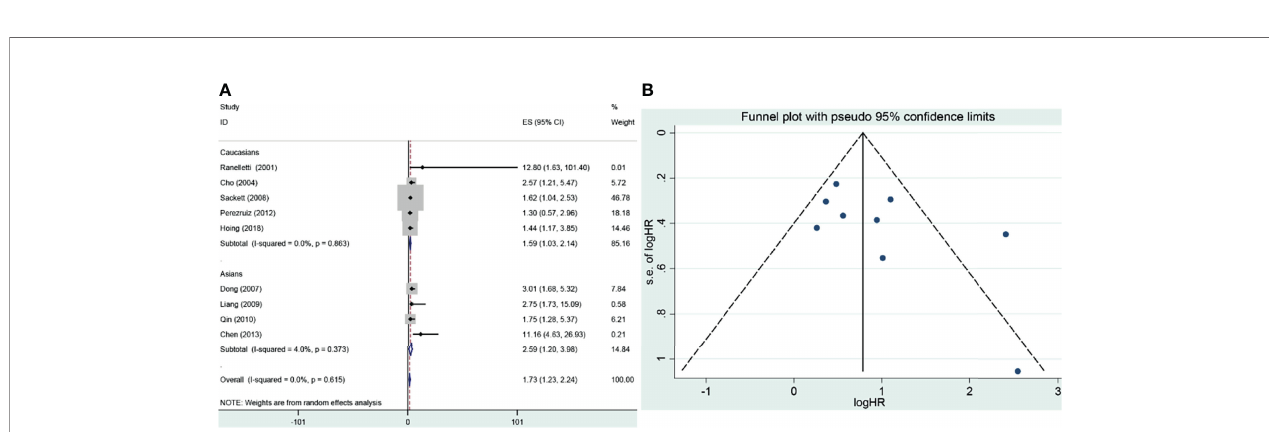
FIGURE 3 | Funnel plots of the association of COX-2 expression with clinical features of laryngeal cancer. (A) Tumor stage for laryngeal cancer. (B) Lymph node metastasis for laryngeal cancer. (C) Recurrence for laryngeal cancer. (D) T stage for laryngeal cancer. OR, odds ratio; CI, con fi dence interval.